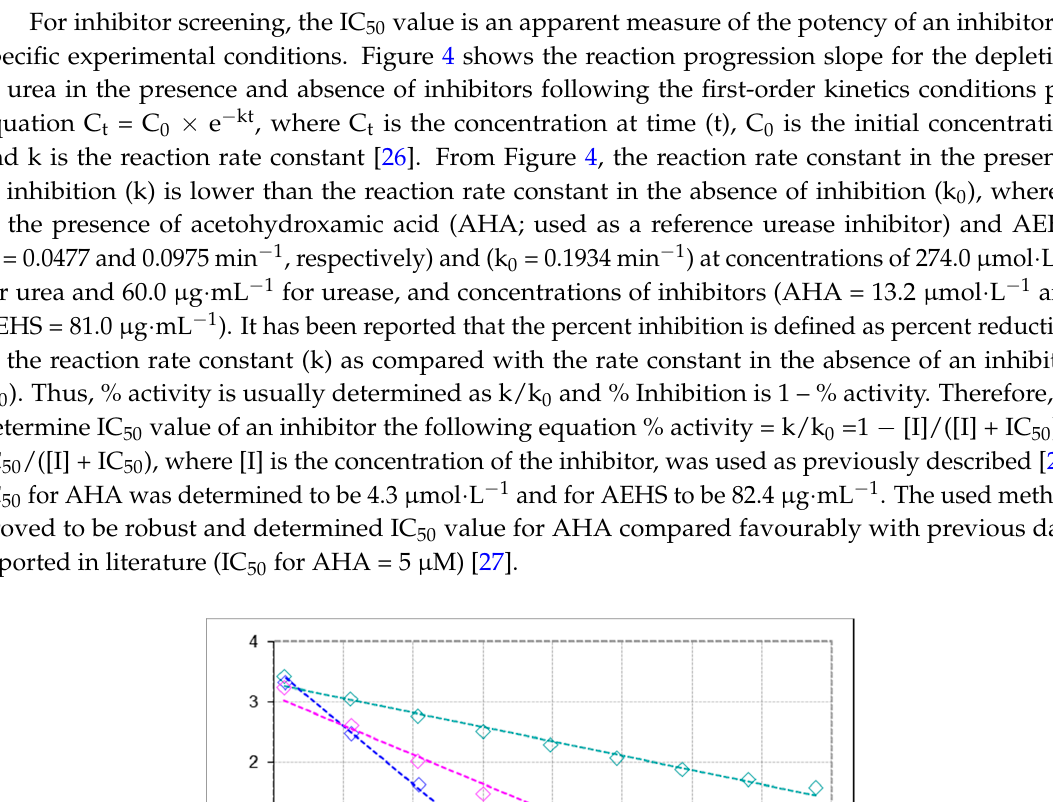
Figure 3. Lineweaver Burk plot for determination of urease kinetic parameters; Michaelis constant ( K m ) and the maximal reaction rate ( V max ). K m = 1888.7 µmol ∙ L − 1 and V max = 259.6 µmol ∙ L − 1 ∙ min − 1 . R 2 = 0.99.